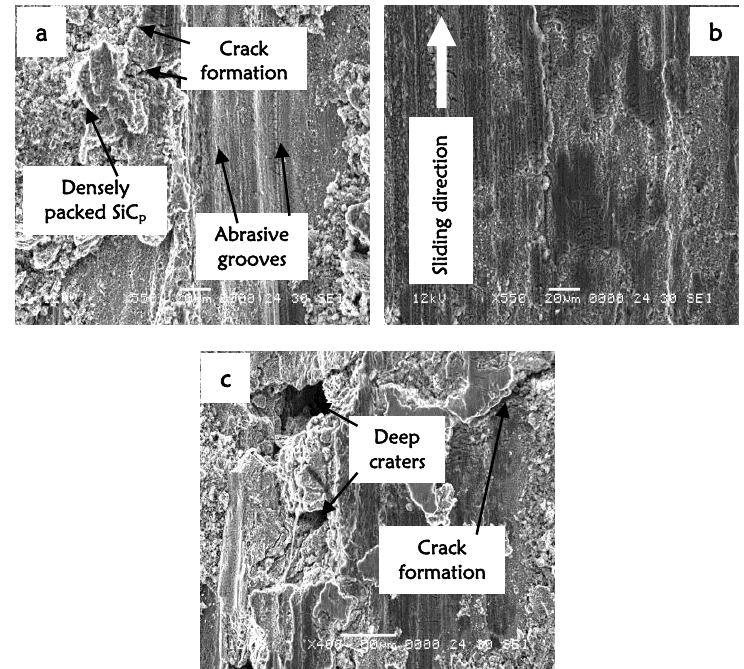
Figure 5: Wear morphology of 15 wt% SiC p Al composite processed at (a) 300 rpm (b) 500 rpm and (c) 700 rpm. The formation of craters, cracks, and abrasive grooves are